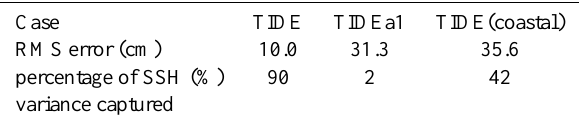
Table 3. The RMS error of the tidal height (cm) and the percentage of SSH variance captured (%) in TIDE and TIDEa1. The values of “TIDE(coastal)” are calculated in the region shallower than